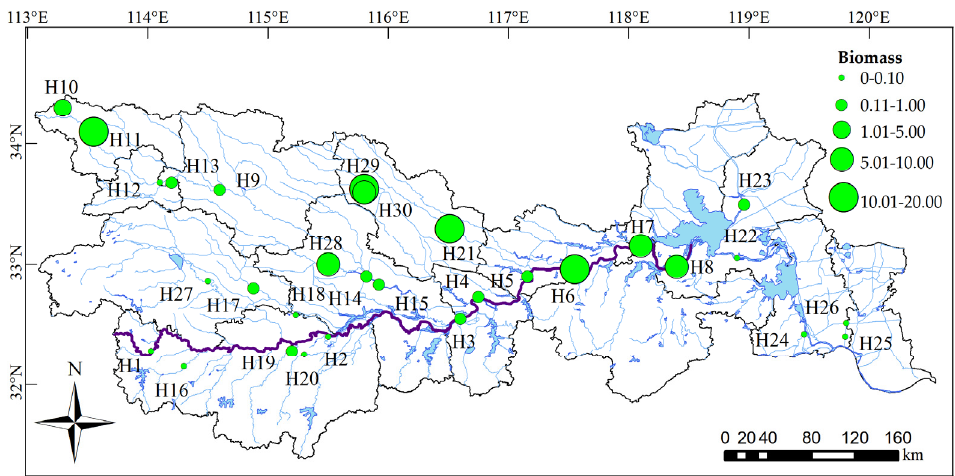
Figure 5. Phytoplankton biomass distribution in the Huaihe River Basin.